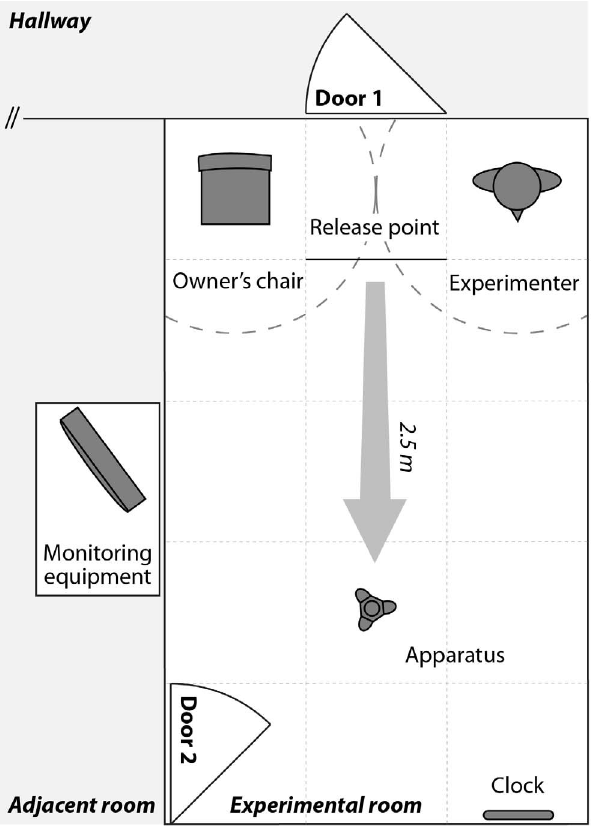
Figure 2. Schematic representation of the experimental set-up. The experimental room was equipped with two doors, one connecting it to the hallway (Door 1) and one connecting it to an adjacent room with monitoring and recording equipment (Door 2). At the beginning of each trial, the dog was released by the experimenter from the release point, which was 2.5 m away from the apparatus. During each trial the experimenter stood on the right side of door 1 – timing the trial with a clock on the opposite wall. The owner either sat on the designated chair on the left side of door 1 or was in the adjacent room – depending on the pre-test trial or the condition of the test trial. The dashed lines indicate the floor markings around the owner’s chair and the experimenter’s position, which were used for later video coding.